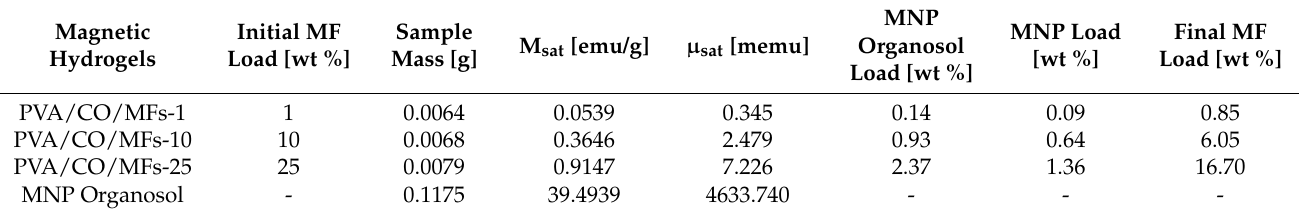
Table 2. Saturation magnetization data and magnetic loading calculations.